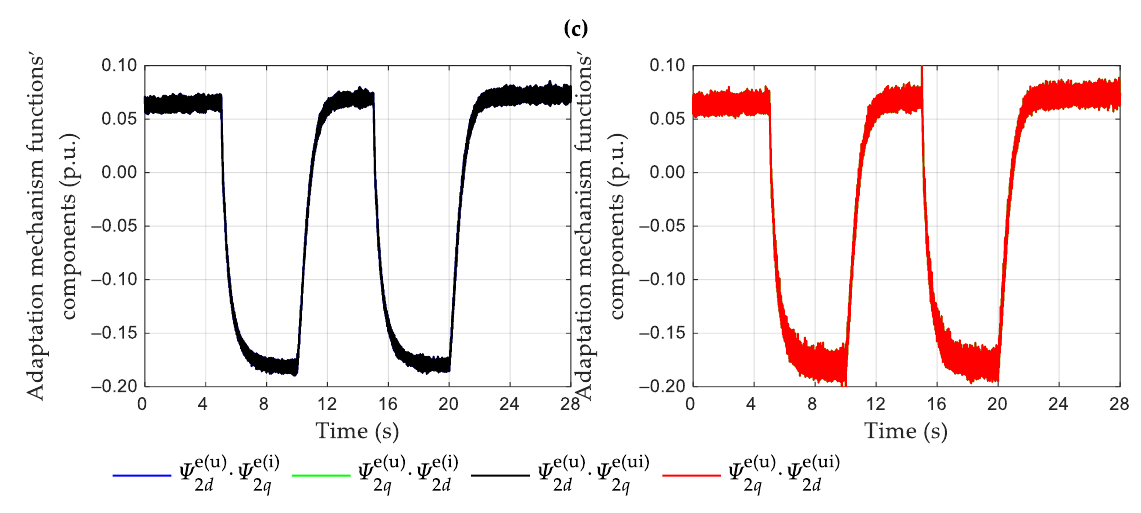
Figure A4. The components of the adaptation mechanism functions returned by the MRAS (u-i) and MRAS (u-ui) during the speed estimation of the tested SR IM: ( a ) the MRAS (u-i) , N = 1 — set D1 parameters; ( b ) MRAS (u-ui) , N = 1 — set D2 parameters; and ( c ) MRAS (u-ui) , N = 2 — set D3 parameters.